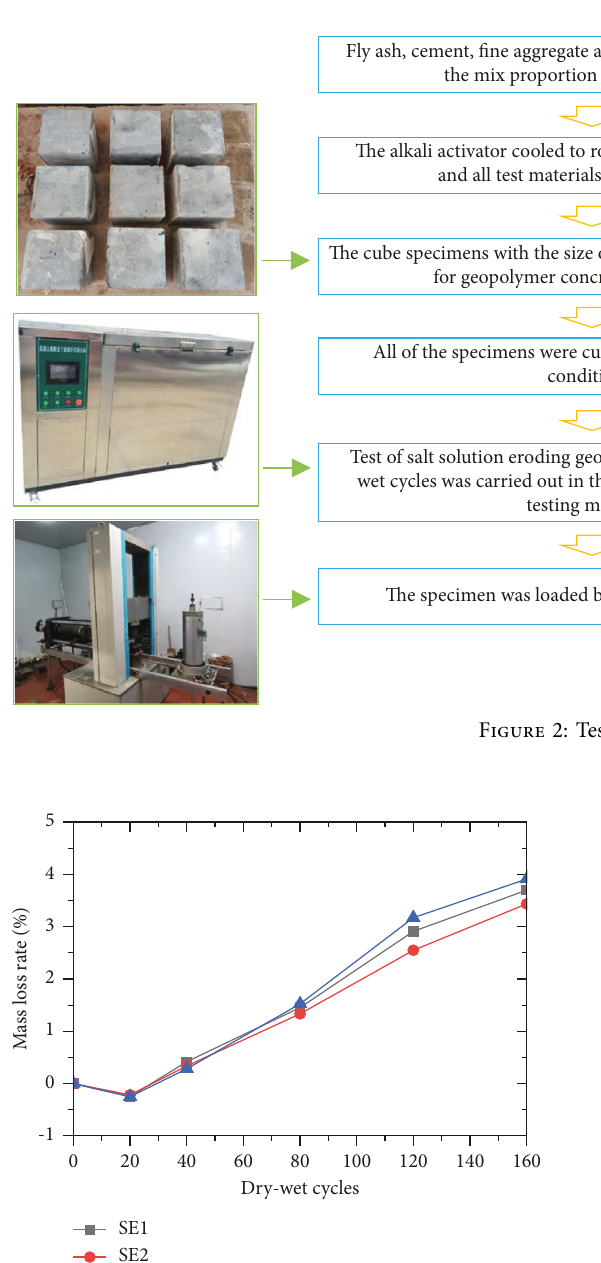
Figure 3: The relationship between the mass loss rate and the dry- wet cycles.